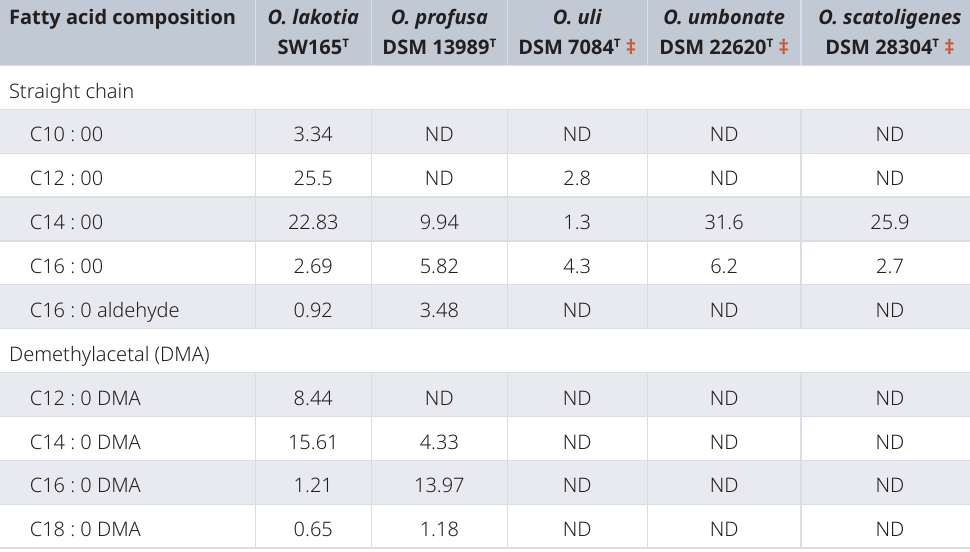
Table 2. Cellular fatty acid compositions of O. lakotia SW165 T and related neighbors. Values are percentages of total fatty acids detected. Fatty acids with contents of less than 1% in all strains are not shown; ND, Not